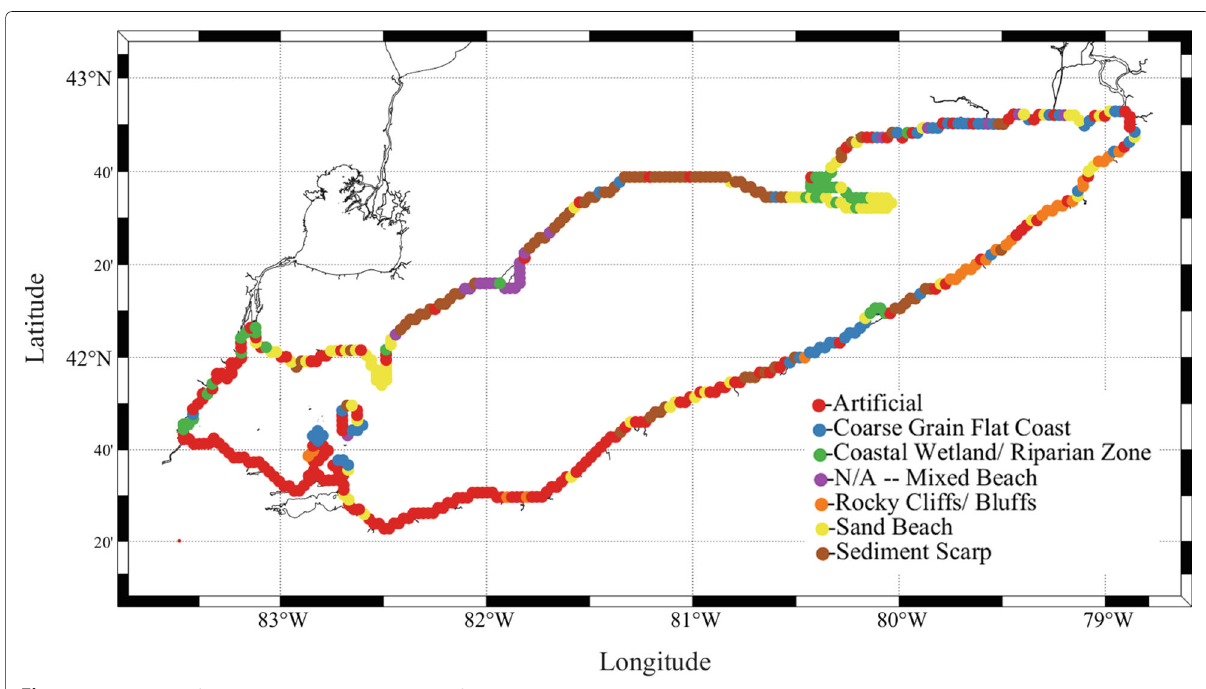
Fig. 1 Beach type classifications interpolated to model grid for Lake Erie